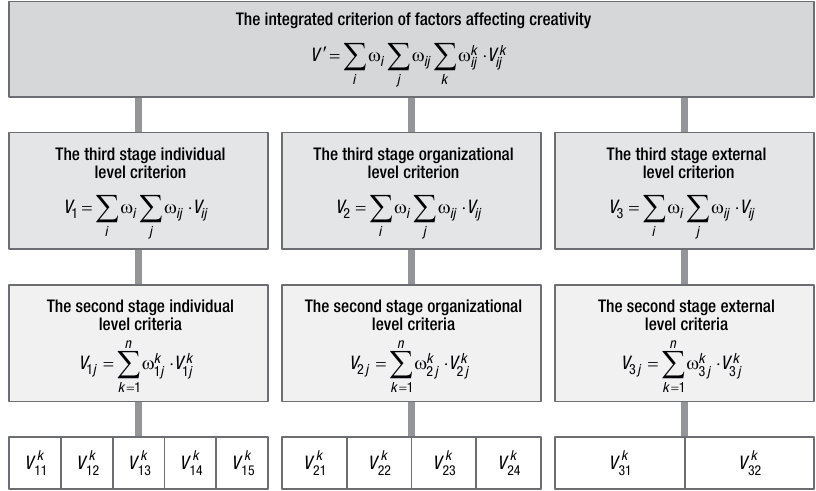
Fig. 2. The sequence of estimating the integrated criterion of factors affecting